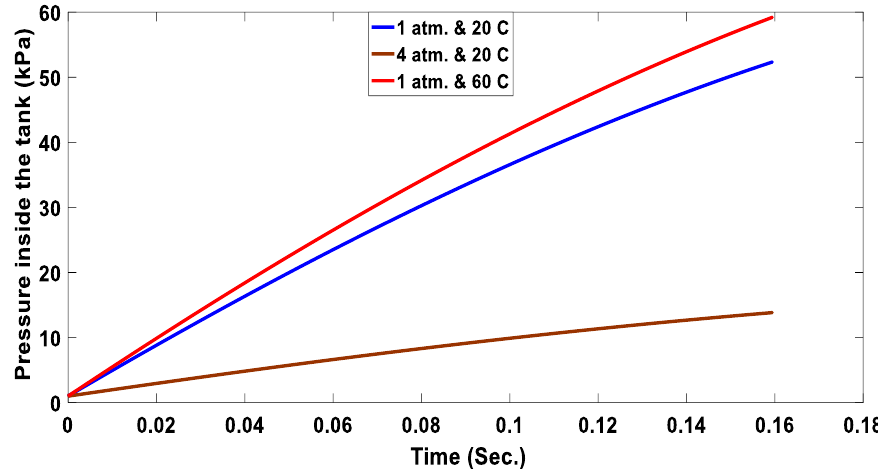
Figure 26. Pressure of hydrogen inside the tank at different operating conditions.